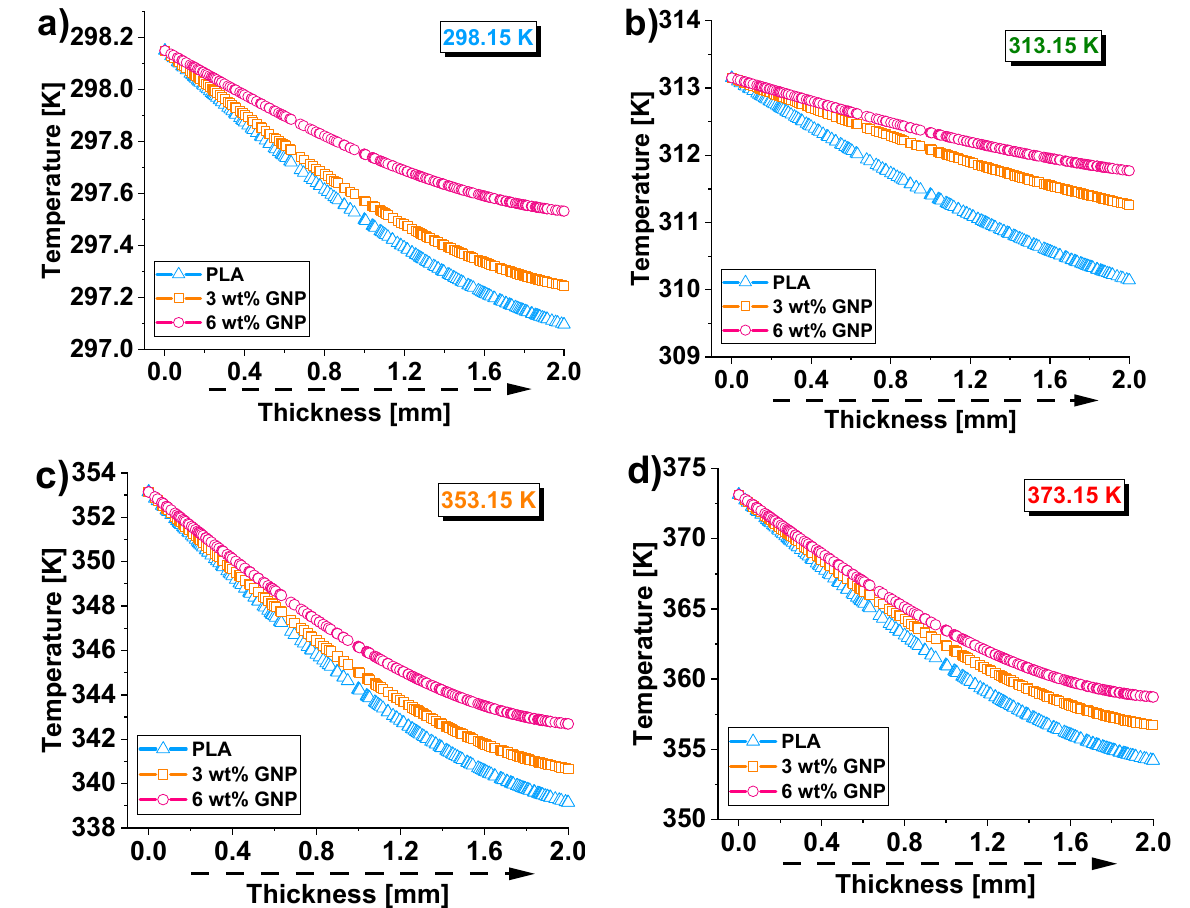
Figure 11. Temperature profiles (evaluated at the half course of each transient phase and alongside the symmetry axis) for the different heat sinks at the different temperature values: 298.15, 313.15, 353.15, and 373.15 K in ( a – d ), respectively.